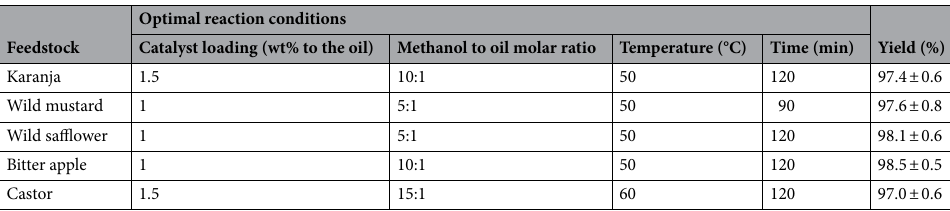
Table 8. Optimal transesterification reaction conditions for different non-edible oils using Fe/SnO/Feldspar catalyst.